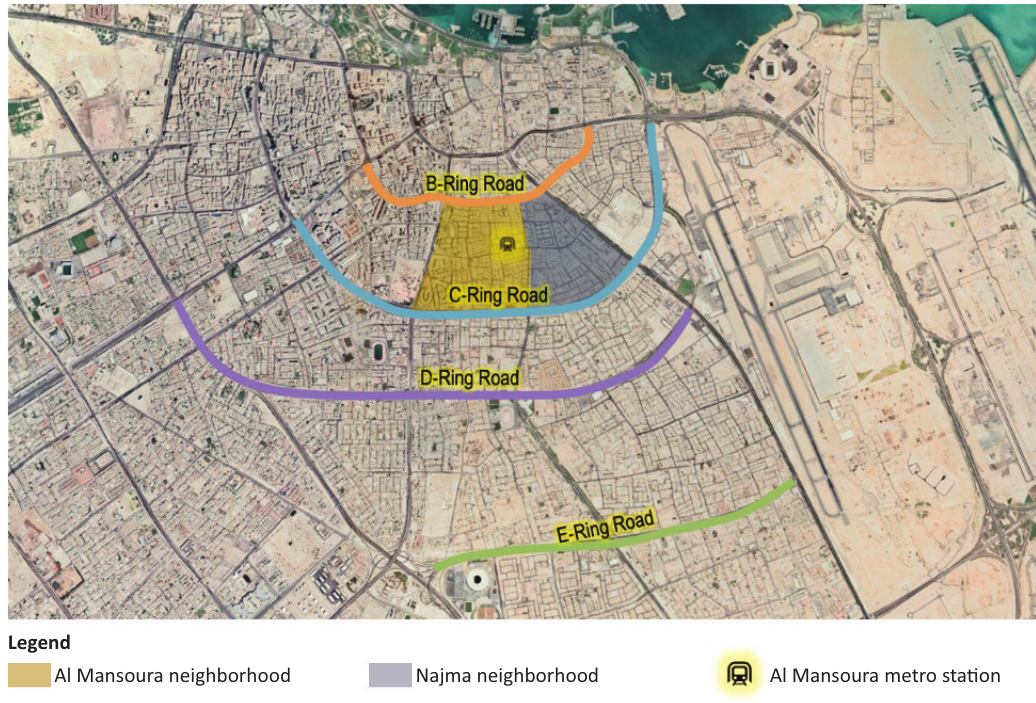
Figure 1. The location of the study area within